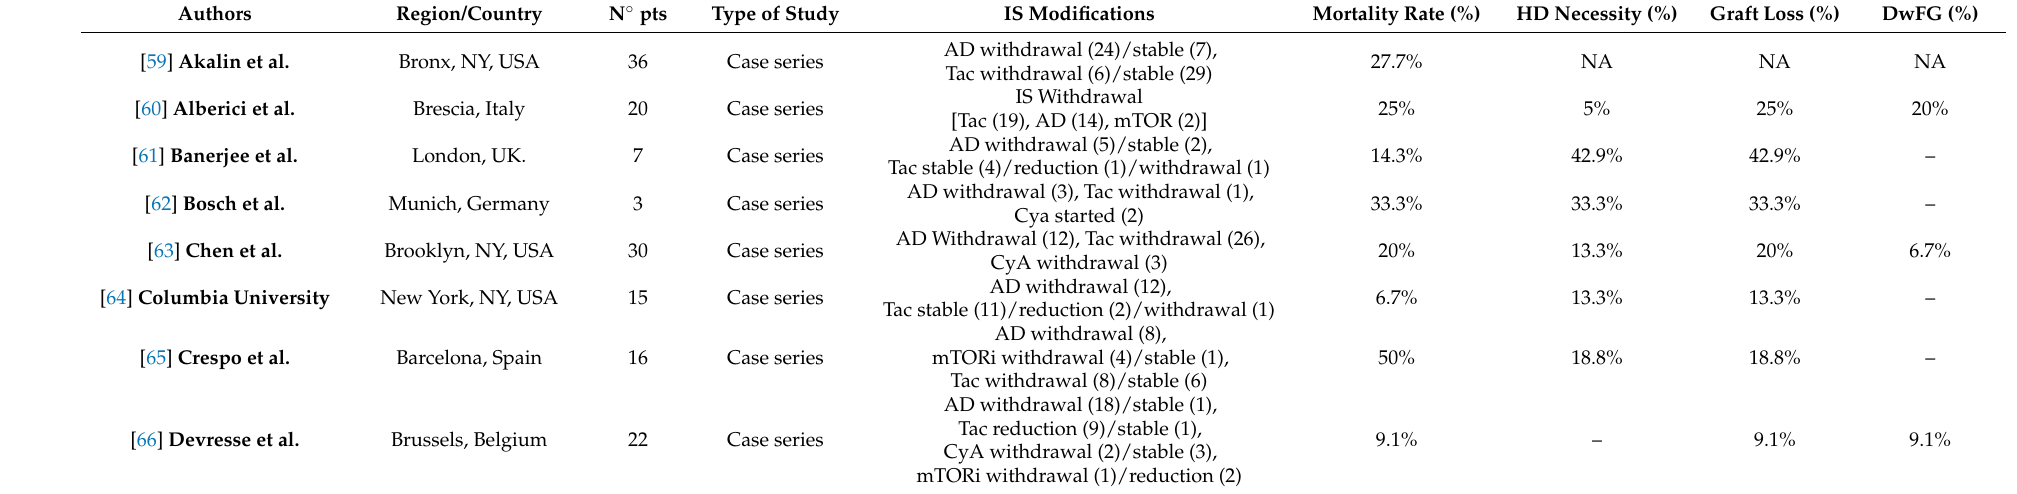
Table 2. Case series and prospective studies of kidney transplant recipients infected with SARS-CoV-2 included in the